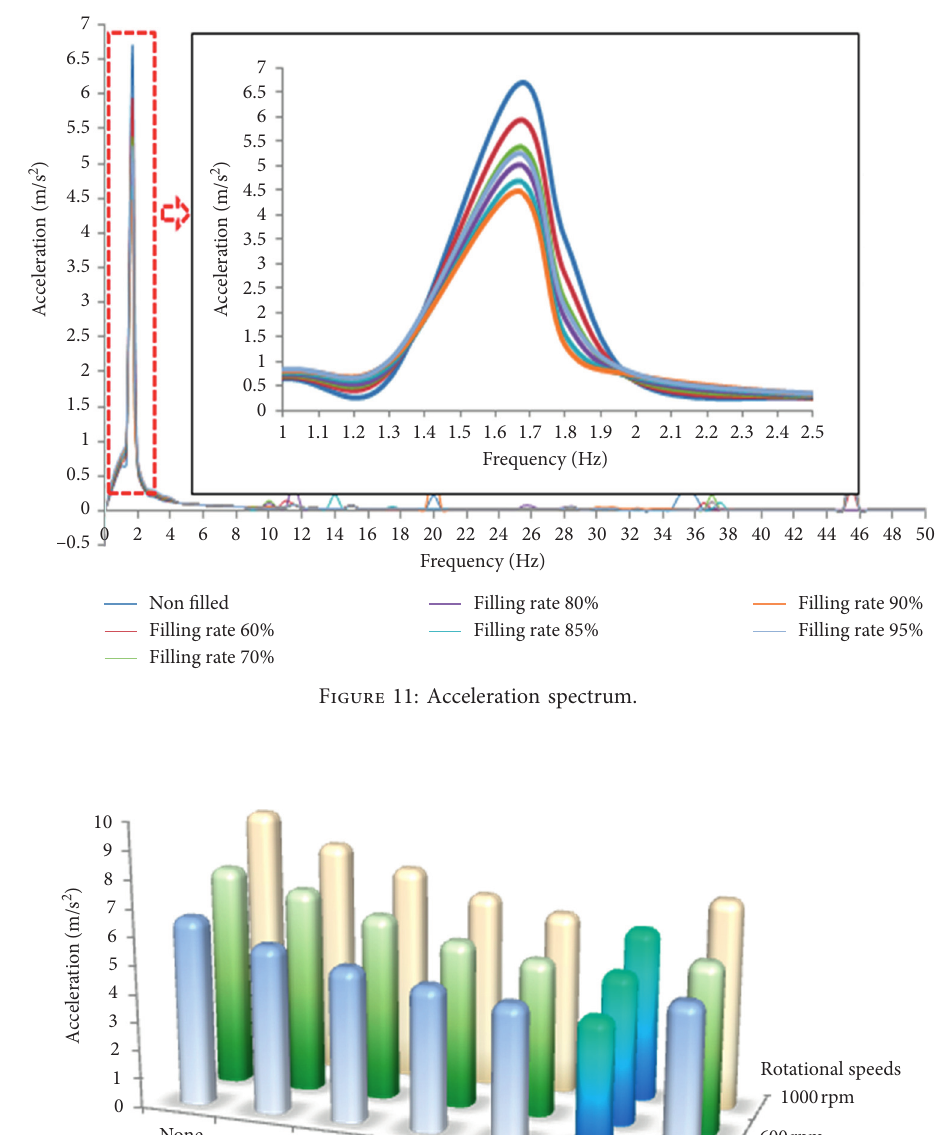
Figure 12: Acceleration response of different particle filling rates at different speeds.